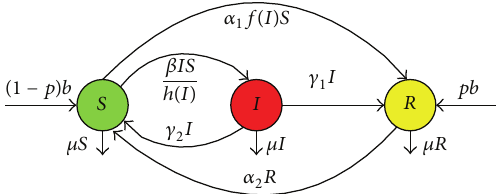
Figure 1: The transfer diagram of the new